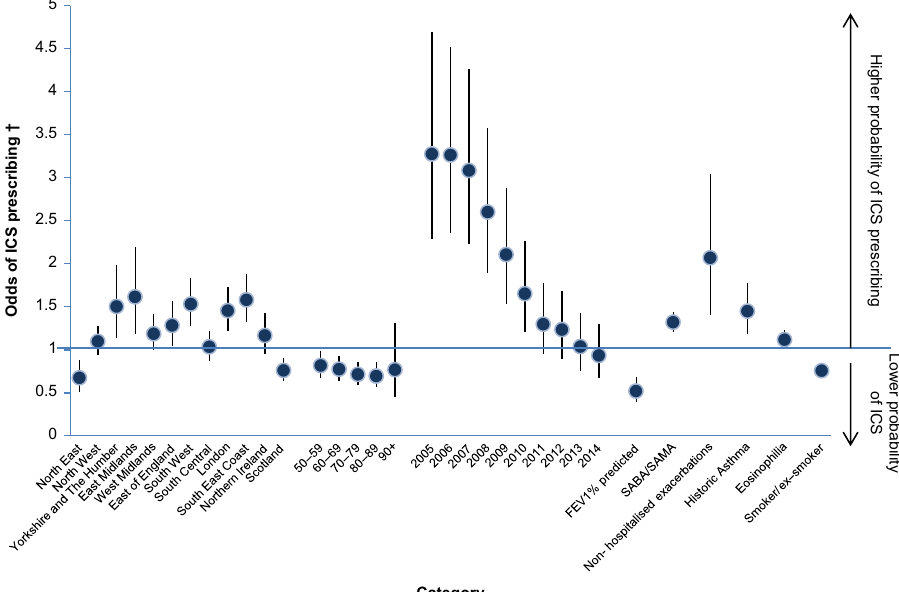
Fig. 4 Logistic regression model excluding concurrent asthma patients. SABA short-acting beta-agonists, SAMA short-acting muscarinic antagonists. † Comparisons were made against a reference category in the case of region (Wales), age (40 – 49 years), and year of diagnosis